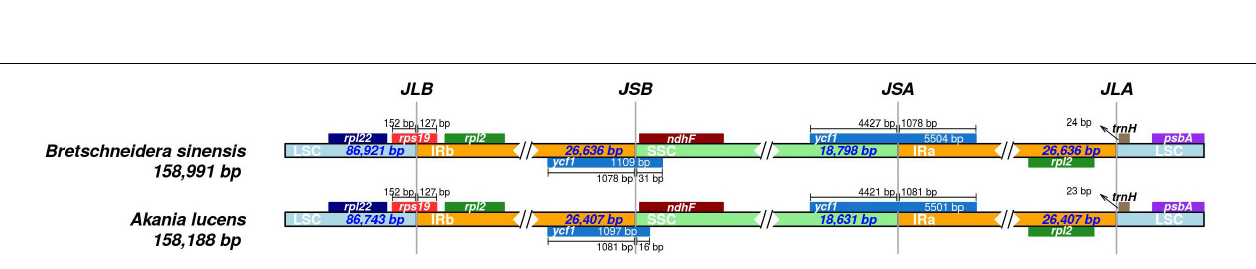
Frontiers in Ecology and Evolution |